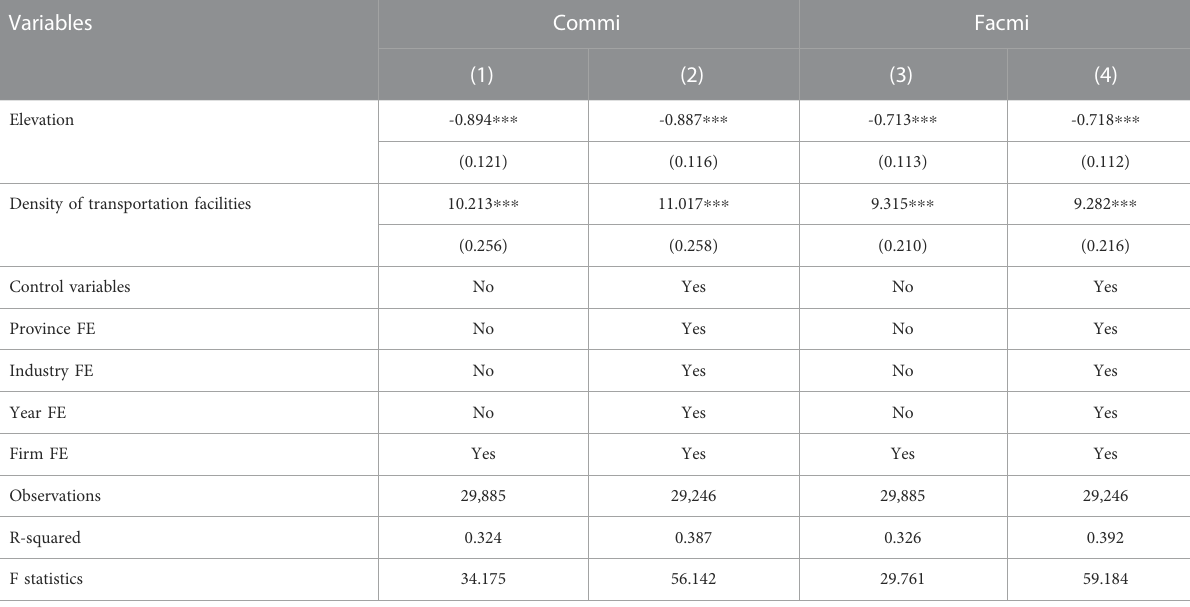
TABLE 3 First-stage estimation: impact of instrumental variables on market integration.